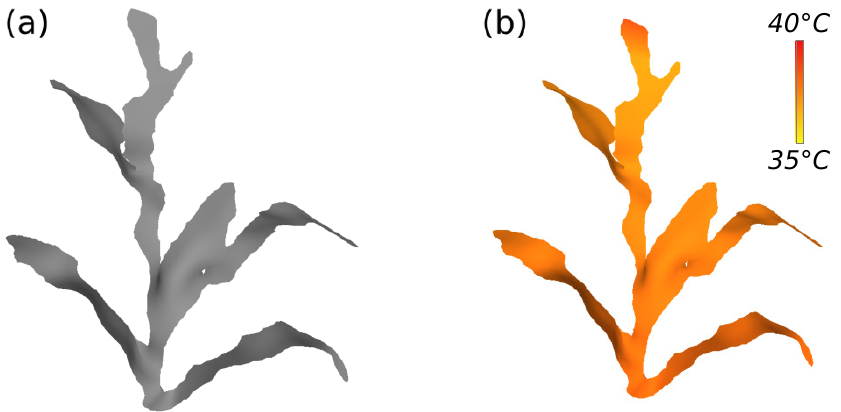
Figure 14. Model and temperature sensor data fusion. ( a ) Model and ( b ) colorized model with data from the temperature